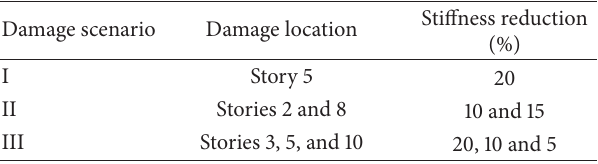
Table 4: The considered damage scenarios in the ten-story shear frame.